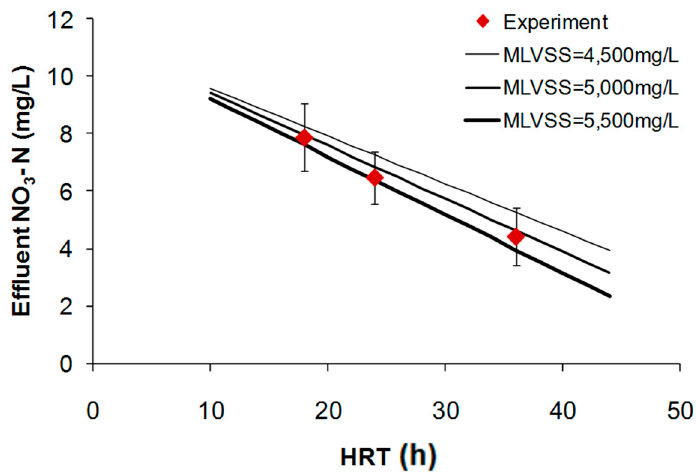
Figure 3. Effect of HRT on effluent nitrate nitrogen concentration.